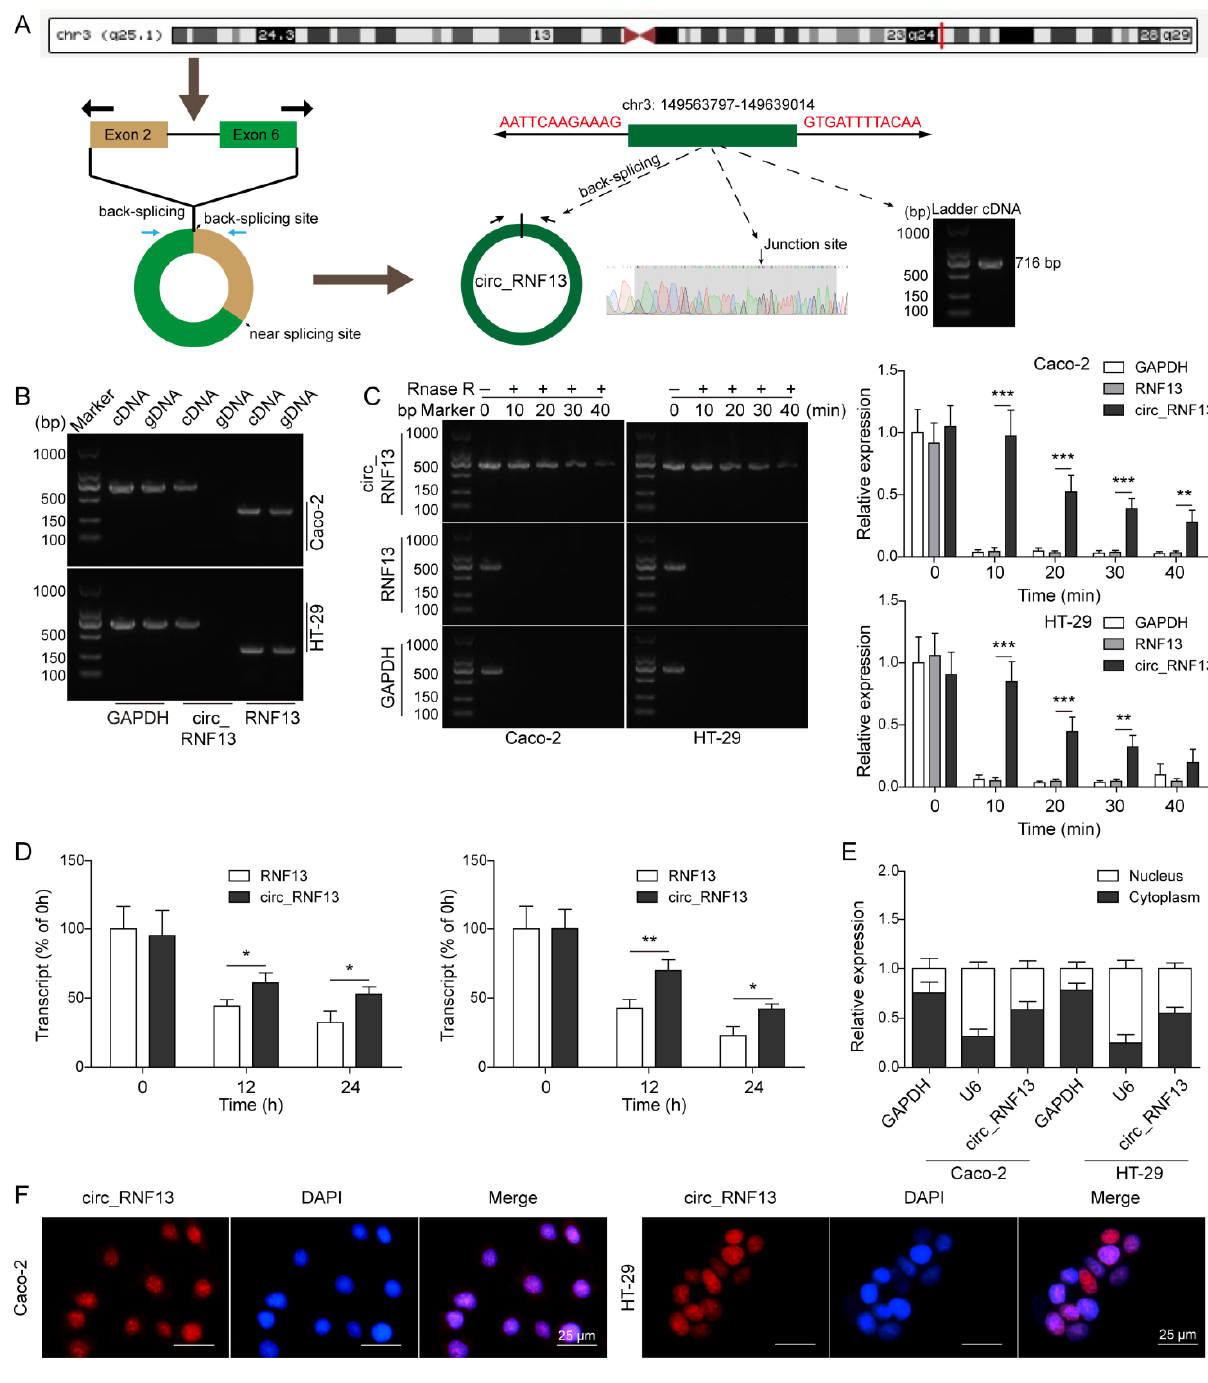
Figure 1. Characterization of circ_RNF13. ( A ) Schematic drawing of circ_RNF13 structure in the chromosome 3q25.1. ( B ) The amplifications of circ_RNF13 or linear RNF13 in cDNA and gDNA fractions were detected using different primers. ( C ) The stabilities of circ_RNF13 and RNF13 upon RNase R treatment were detected by qRT-PCR. ( D ) The stabilities of circ_RNF13 and RNF13 upon Actinomycin D treatment were detected by qRT-PCR. ( E ) The nuclear and cytoplasmic expression of circ_RNF13 were detected by subcellular fractionation assay. ( F ) The subcellular localization of circ_RNF13 in HT-29 and Caco-2 cells was assessed by FISH. Red, circ_RNF13; blue, DAPI. Scale bar, 25 μ m. Each experiment was performed at least three times independently. *, p < 0.05, **, p < 0.01, ***, p < 0.001.